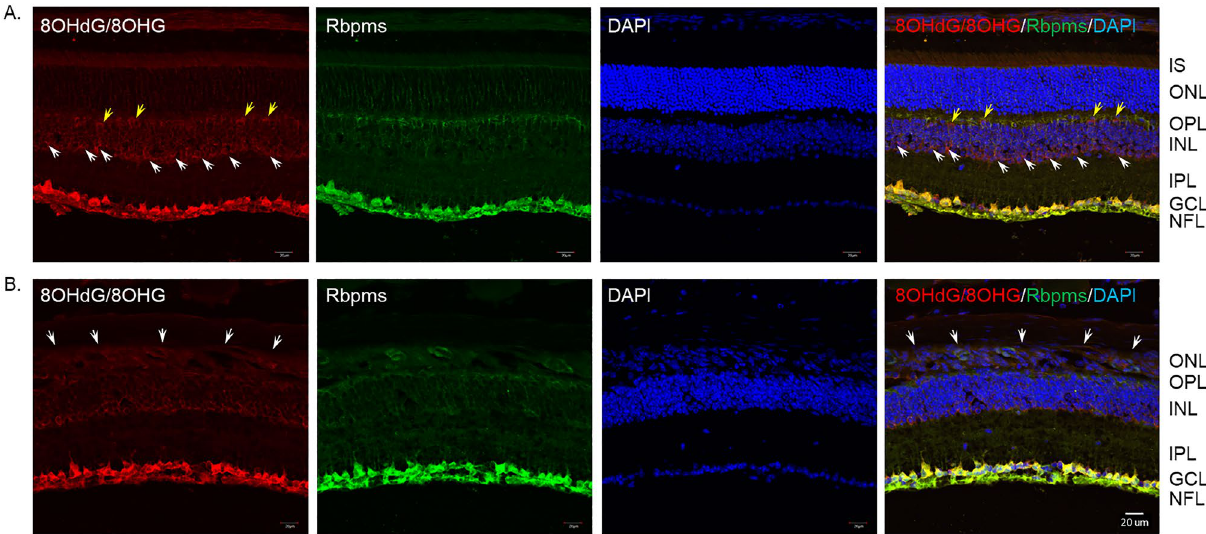
Figure 5. DNA/RNA oxidative damage in retinas of 2.5-month-old rd10 mouse. Representative confocal images of control (n = 3) and rd10 (n = 3) mouse retinal sections that were immunostained with antibodies for 8OHdG/8OHG. In both control and rd10 retinas, 8OHdG/8OHG staining was primarily localized to Rbpms- positive RGC somas in the GCL and RGC axons in the NFL. ( A ) In addition to RGCs, 8OHdG/8OHG relatively weak staining was present in cells within INL, particularly those adjacent to the IPL (most likely amacrine cells; white arrows) and sparsely distributed cell adjacent to OPL (most likely horizontal cells; yellow arrows). ( B ) A severe degeneration of photoreceptors and disorganization of the ONL of rd10 mouse retinas (white arrows) is present. No notable change in the pattern or intensity of the 8OHdG/8OHG staining in the GCL of rd10 mouse plexiform layer; GCL, ganglion cell layer; NFL, nerve fiber